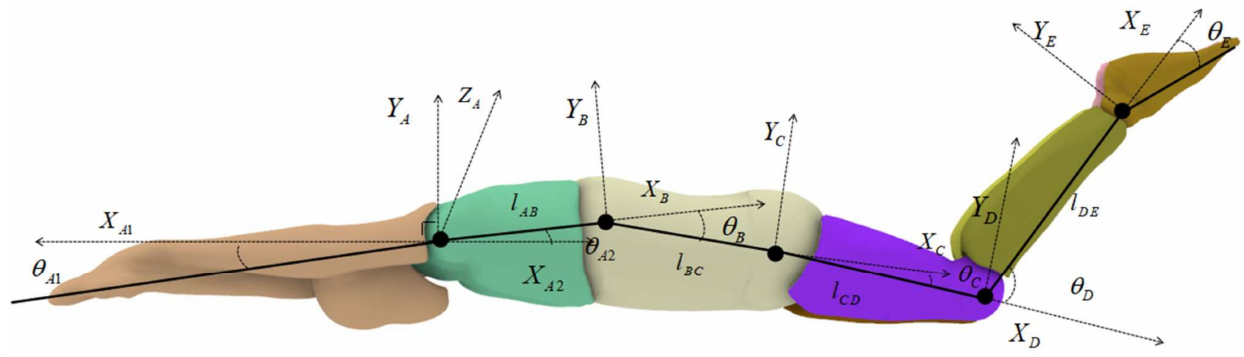
Figure 2. Diagram of the D–H model of Figure 2 is the D–H model schematic diagram of the undulatory underwater swimming. A , B , C , D , and E represent the shoulders, upper waist, hips, knees, and ankles, respectively, and l AB , l BC , l CD , and l DE are the distances from A to B , B to C , C to D , and D to E , respectively. Variables θ A 1 and θ A 2 are the angles between the limb and the horizontal position; θ B , θ C , θ D , and θ E are the angles between the adjacent joints.